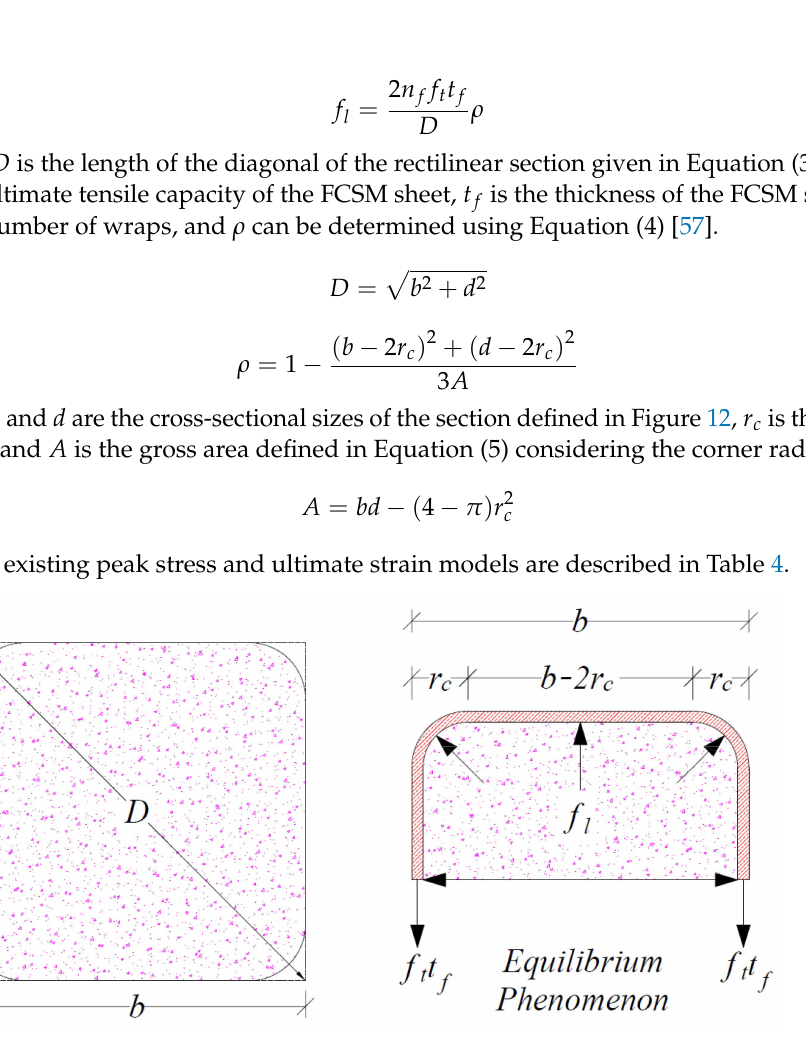
Figure 12. Equilibrium between the outward bursting pressures and axial forces in FCSM wraps. Table 4. Model expressions of existing peak compressive stress and ultimate strain models for confined